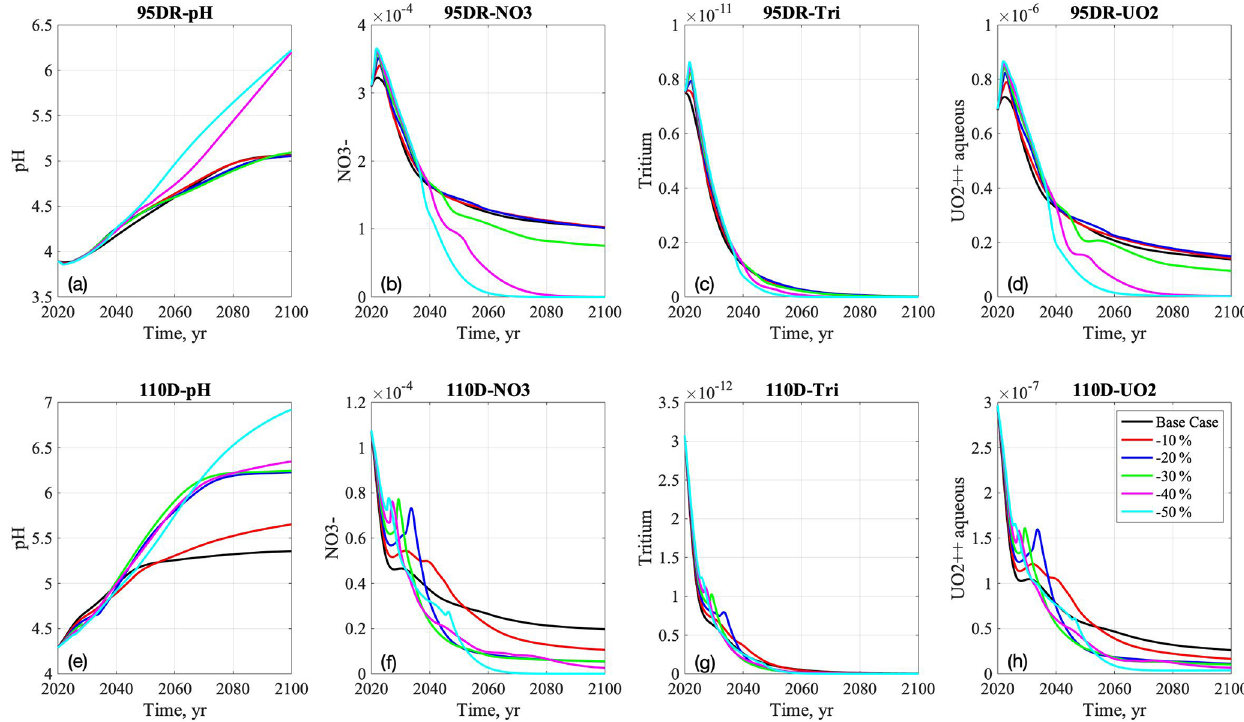
Figure 8. Breakthrough curves of pH, nitrate, tritium, and aqueous uranium at the source-zone well (a–d) and downgradient well (e–h) in the base case and decreasing precipitation scenarios from 2020 to